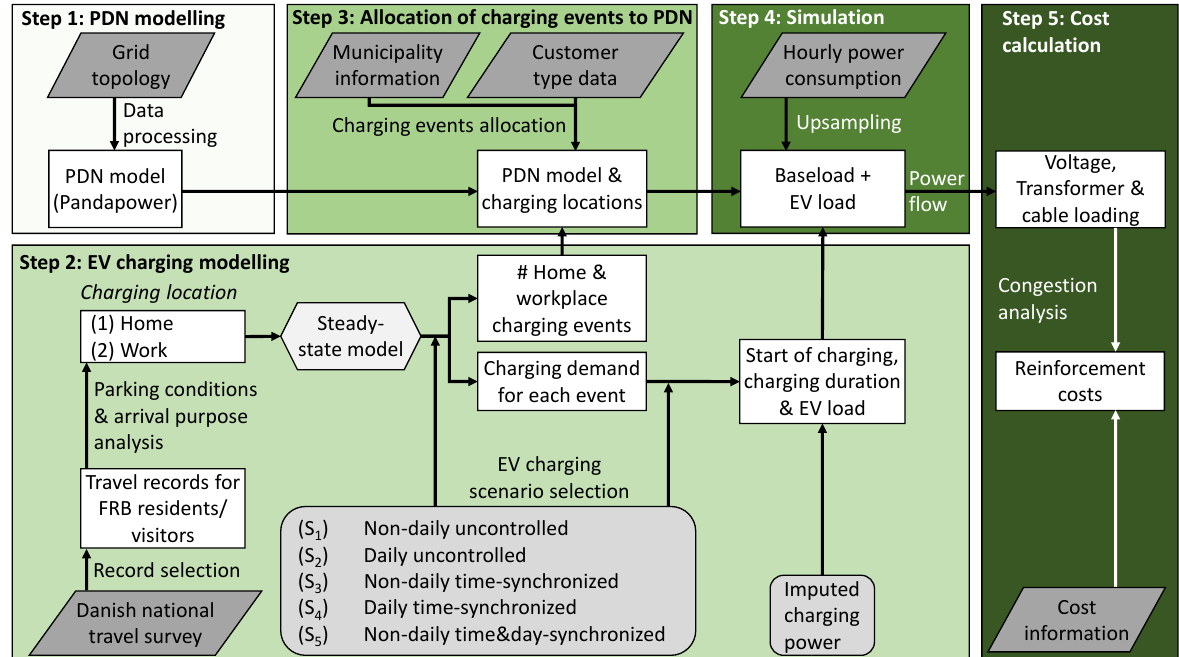
Figure 1. Methodology of the paper to determine the impact of different charging strategies on the power distribution network of Frederiksberg (FRB). While dark-gray-shaded rhomboids depict the input data, gray-shaded shapes represent the external parameter. The light-gray-shaded hexagon represents the external models [35] used in this work. White-shaded rectangles illustrate results obtained in each step of the